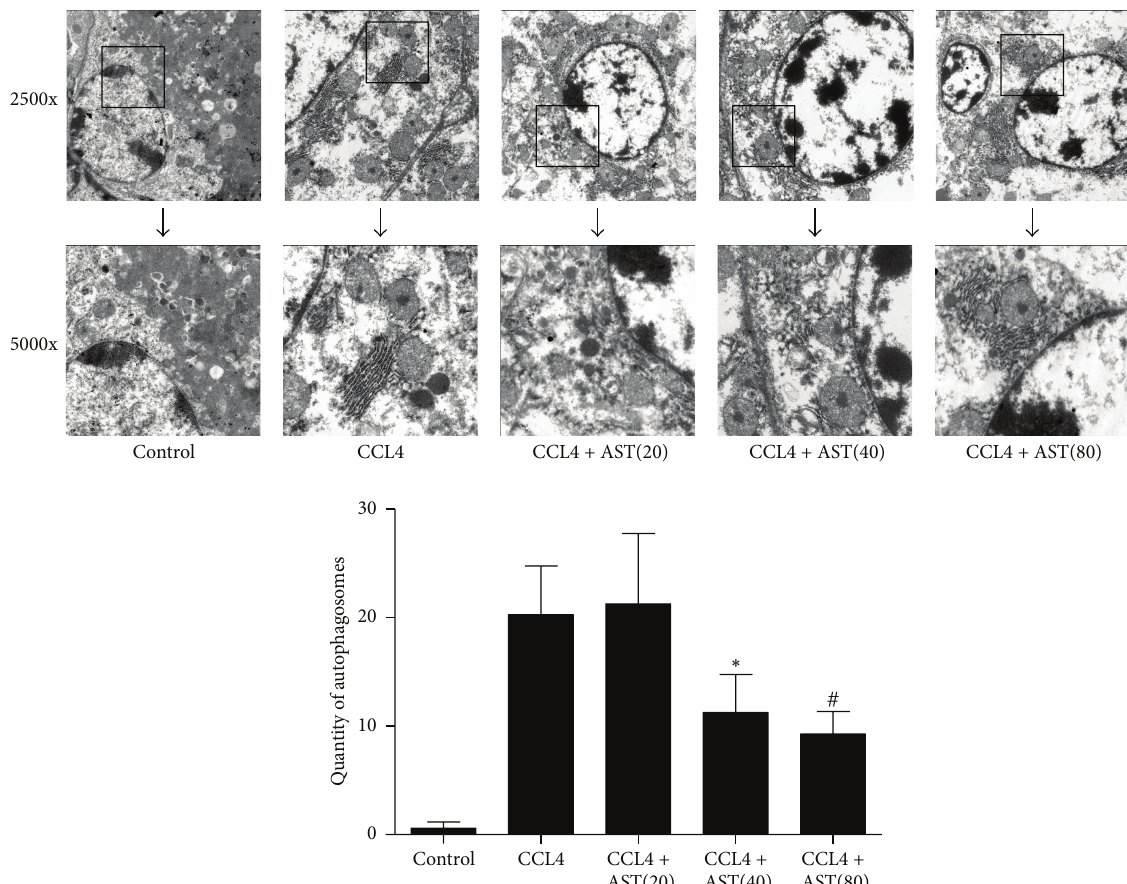
Figure 6: Effect of astaxanthin on the formation of autophagosome. As shown in picture, the amount of autophagosome obviously increased compared to control group. After astaxanthin (40mg/kg and 80 mg/kg) treated, the amount of autophagosome significantly decreased, and the ultrastructure of cells exhibited more integrated (autophagosome was indicated with “ → ”) (original magnification: ×2500 and ×5000